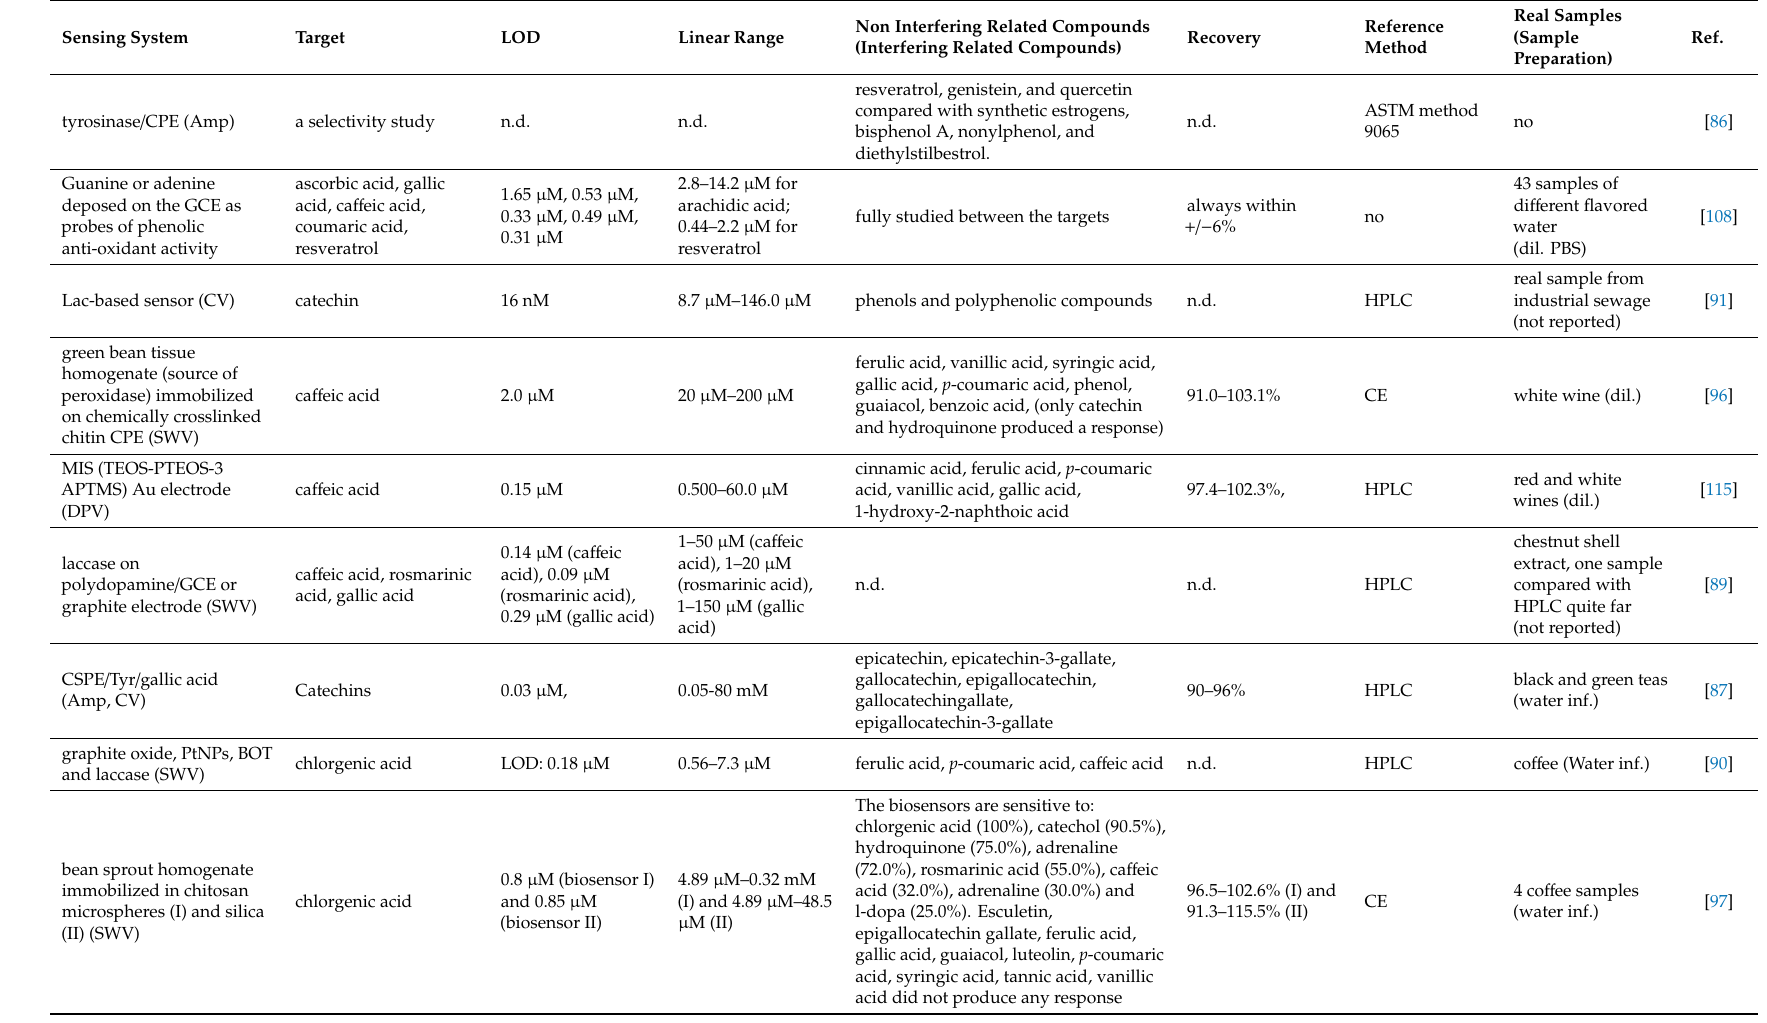
Table 2. Performance of electrochemical systems with recognition